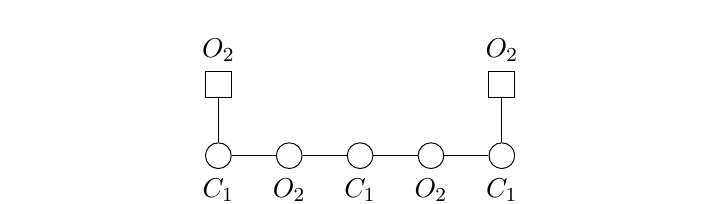
Figure 71. Quiver obtained from brane system in the fourth row of table 6. Its Higgs branch is M H = A [ A 3 3 .